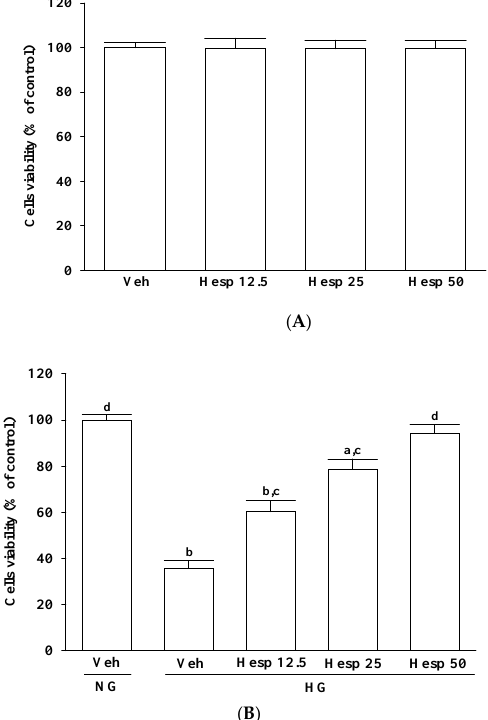
Figure 1. Cytotoxicity of hesperidin to RGC-5 cells. The RGC-5 cells were cultured with normal (NG) or high glucose (HG) plus hesperidin at concentrations of 12.5 (Hesp 12.5), 25 (Hesp 25), or 50 (Hesp 50) µ mol/L for 48 h. ( A ) Effects of treatments on cell viability in RGC-5 cells cultured with normal glucose concentration; ( B ) Effects of treatments on cell viability in RGC-5 cells cultured with high glucose concentration. The